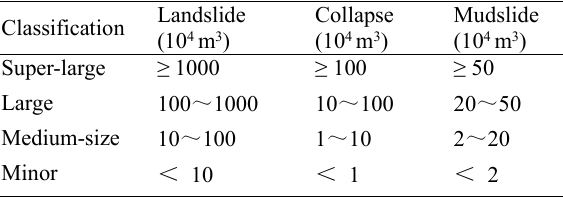
Table 1. Scale division of landslides, collapses and